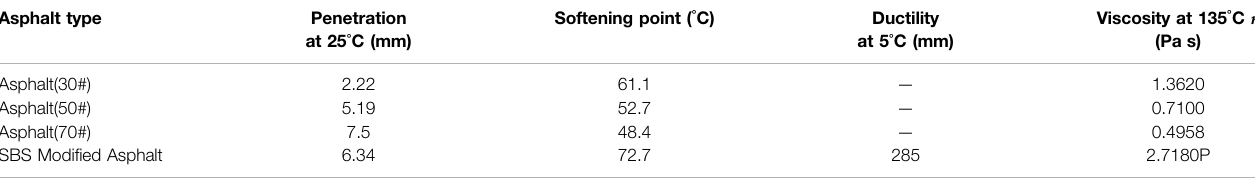
TABLE 2 | Test results of main technical properties of asphalt. Asphalt type